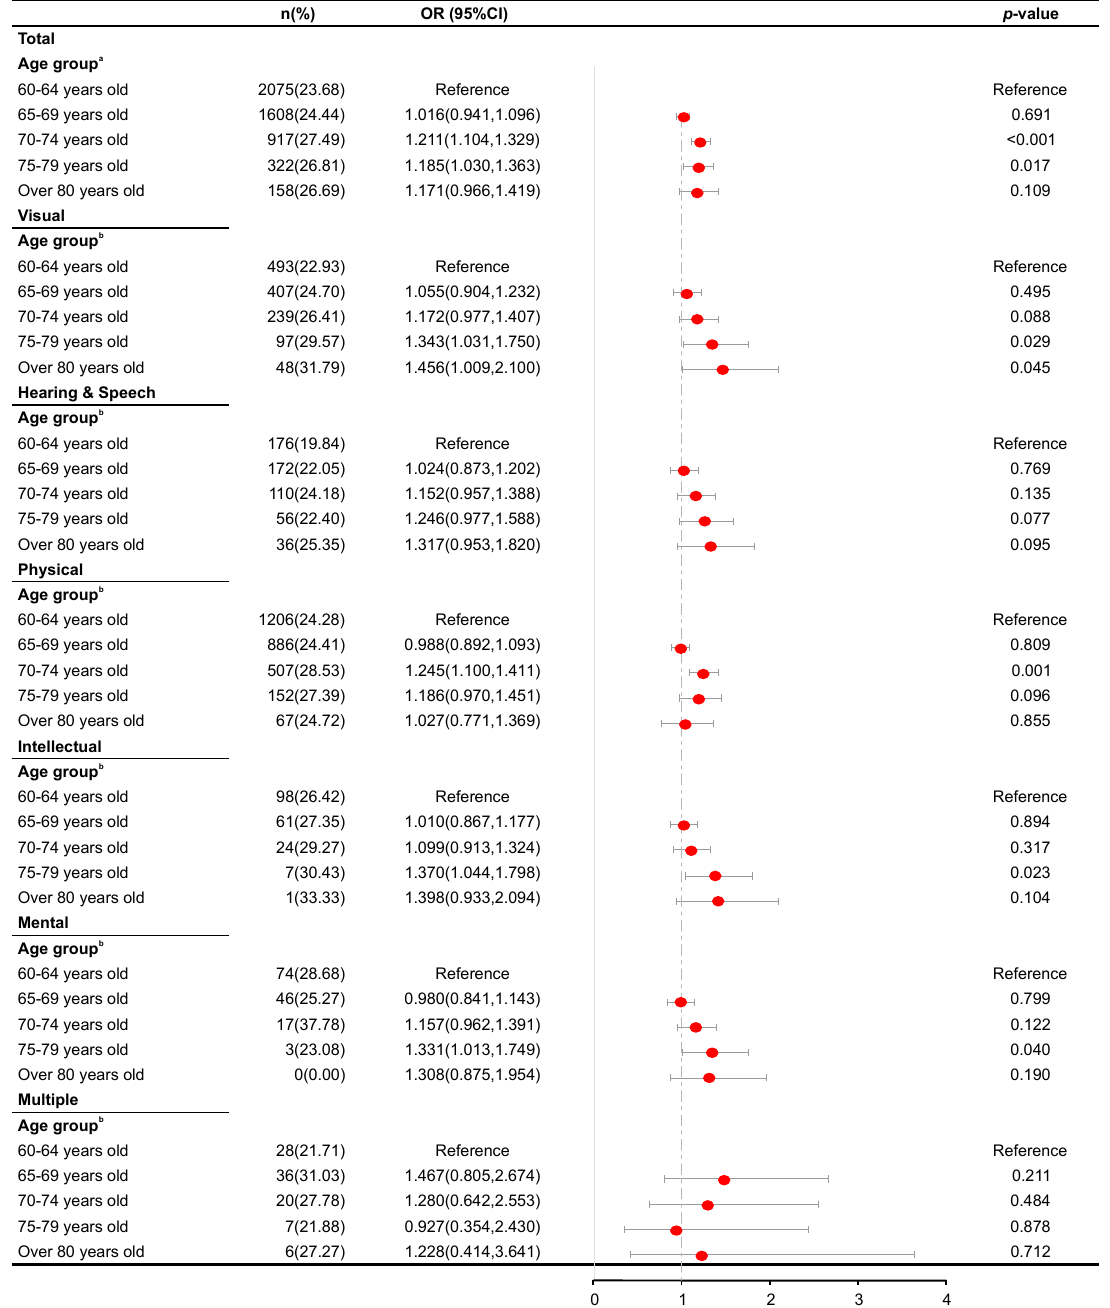
Figure 2. Results of a logistic regression analysis of hyperglycemia according to age group across disability types. a Adjusted for sex, residence permit, education level, marital status, disability type, and disability severity. b Adjusted for sex, residence permit, education level, marital status, and disability severity.